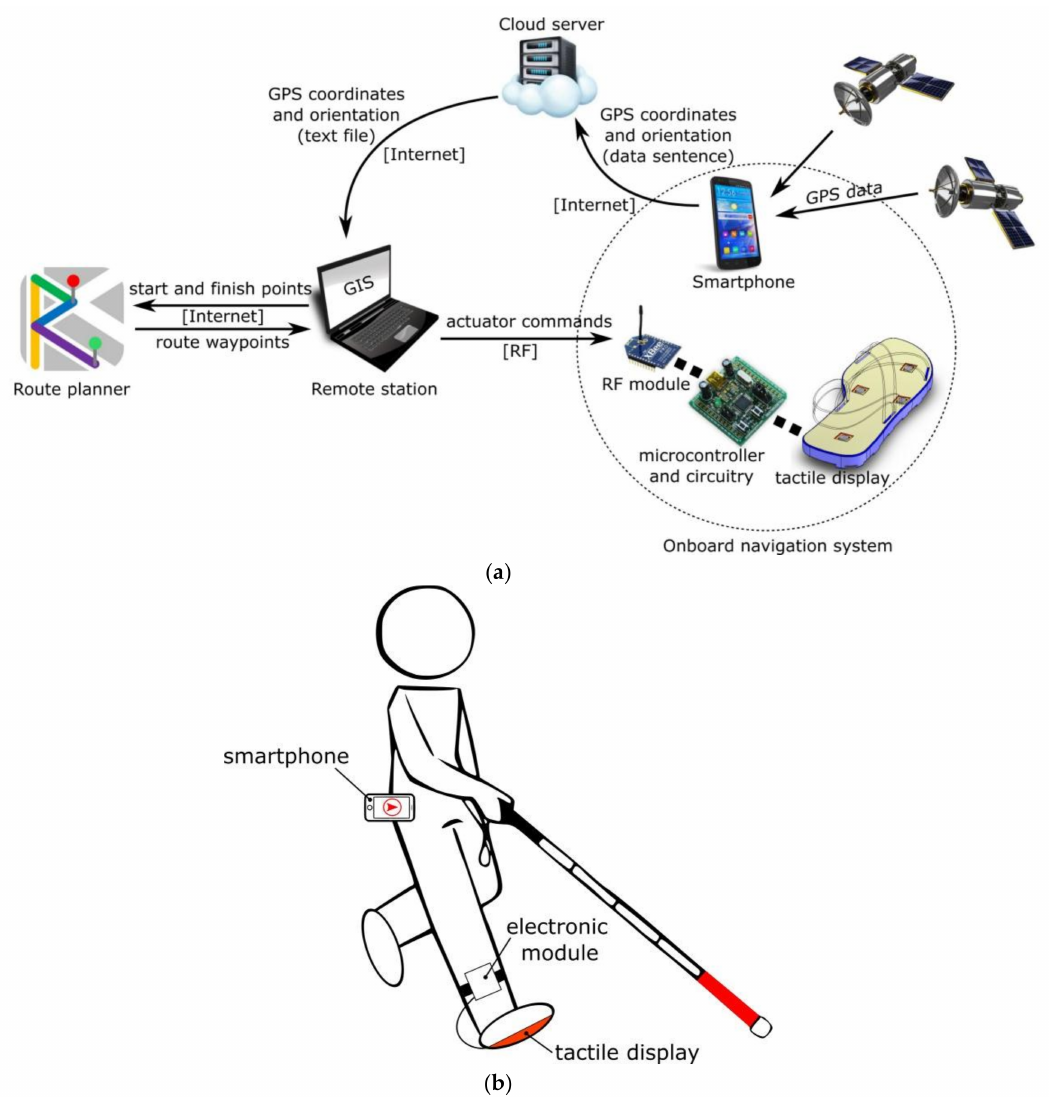
Figure 2. The assistive navigation system: ( a ) main components and operation principle; ( b ) Depiction of a blind pedestrian using the device. White cane or guide dog can be used in conjunction with the device (RF: